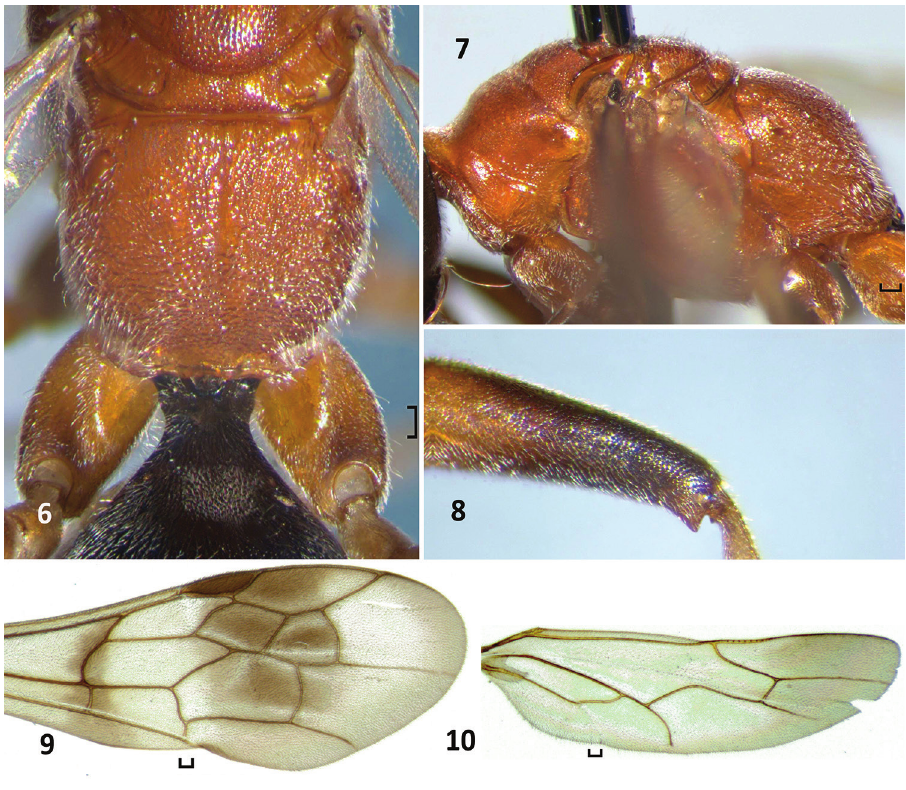
Figures 6–10. Nipponodipogon orientalis Loktionov, Lelej, Xu, sp. n., female, paratype. 6 Mesoscutellum, metanotum, metapostnotum, propodeum and T1, dorsal view 7 Mesosoma, lateral view 8 Metafemur, outer lateral view 9 Fore wing 10 Hind wing. Scale bars 0.1